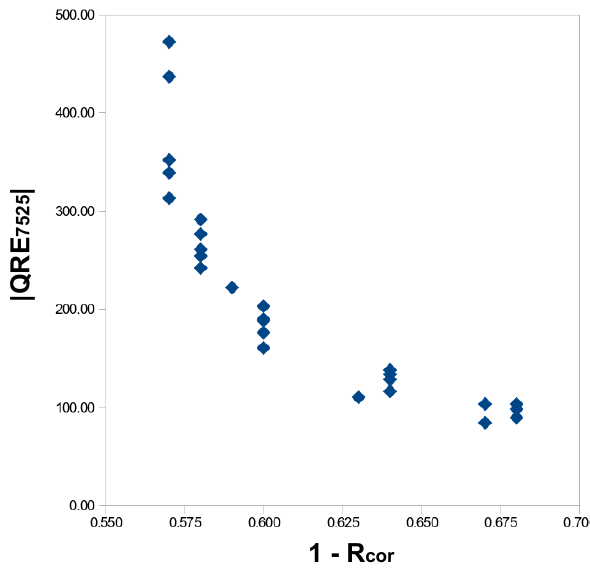
Fig. 11. The scatter-plots of two model performance indicators (in (entire) basin-scale average values) from all scenarios with varying (cid:12) (cid:12) aquifer properties: (cid:12) QRE 7525 (cid:12) (y-axis) and ( 1 − R cor ) (x-axis).